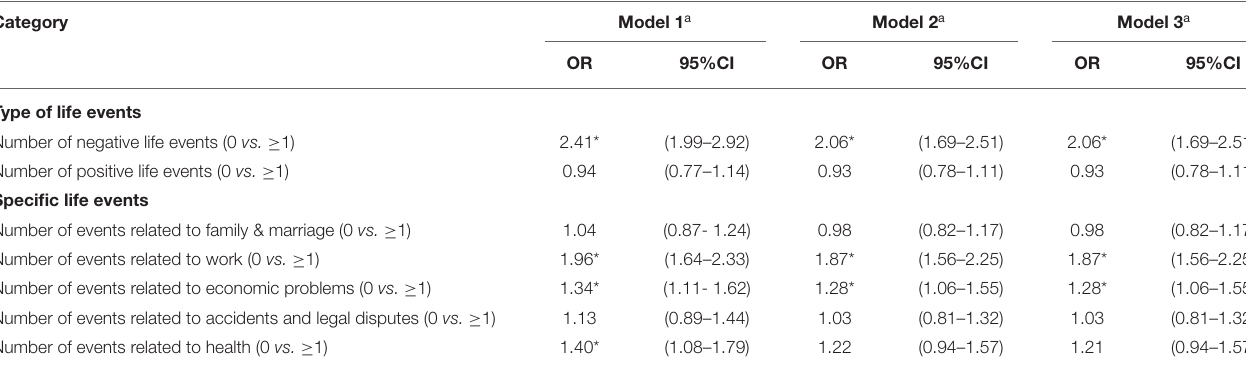
TABLE 4 | Longitudinal associations between different type of life events at baseline and self-reported fatigue at follow-up.